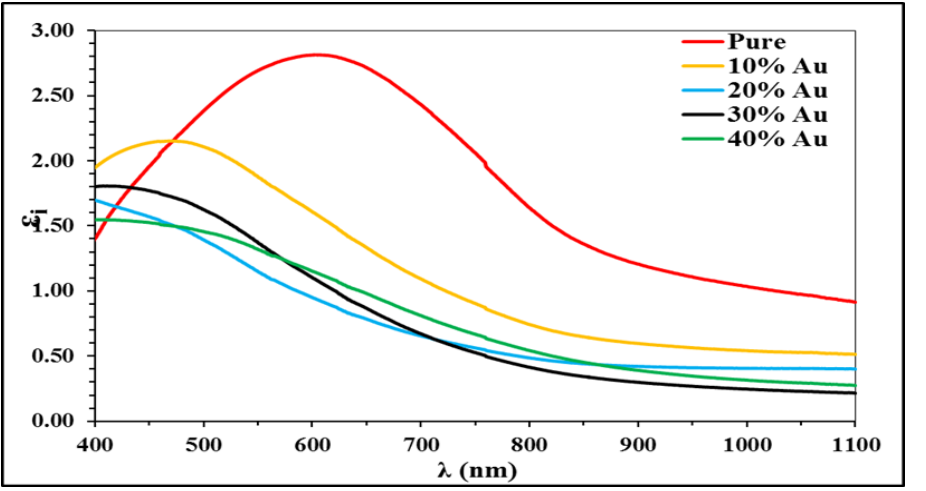
and doped of Au (0, 10, 20, 30 3 = 400 ˚C. a